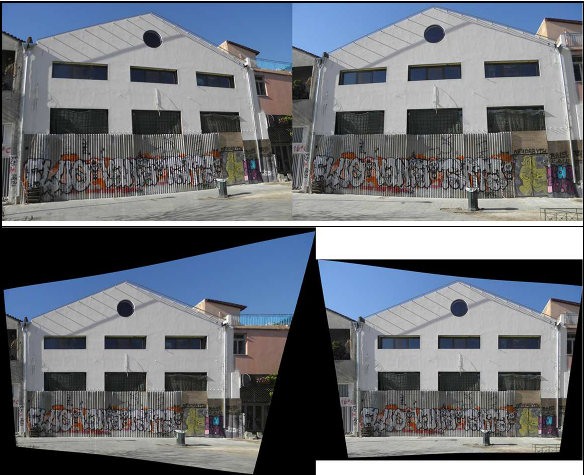
Figure 10. Final rotated images of the above pair (image axes convergence of